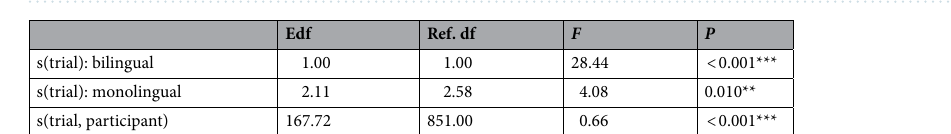
Figure 3. Analysis of smooth terms in a generalized additive mixed model reveals that the difference between bilinguals and monolinguals in proportion of looking at the changing stimulus is statistically significant ( p < 0.05) between Trials 5 and 13. This suggests that the bilingual group noticed the changing stimulus earlier than the monolingual group. However, the model is not an improvement on a pared down version of the model which contains no group terms. We must therefore interpret these findings with caution.